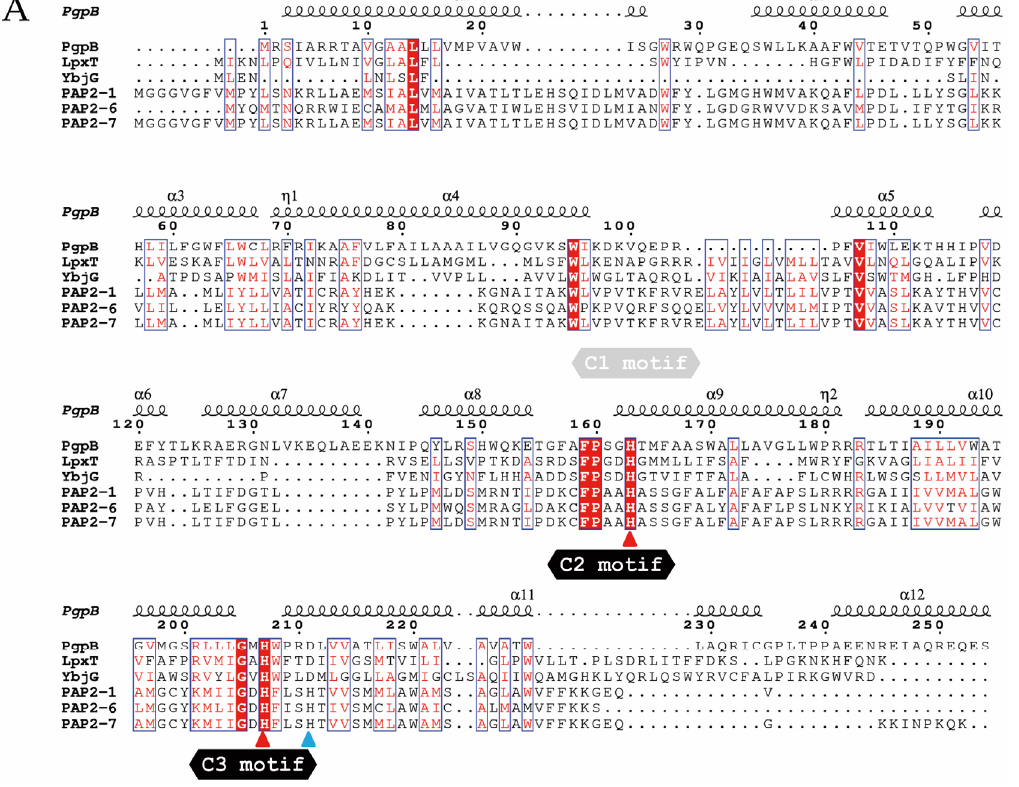
Figure 8. Structural determinants of hPAP2 and DAGK proteins. Multiple sequence alignments were performed by Clustal X 2.0 and emulated by EsPript 3.0. ( A ) Secondary structure elements of PgpB (4PX7) are shown above aligned PAP2 proteins, whose sequences are as follows: PgpB, NP_415362; LpxT, CQR81684; YbjG, WP_061361528; PAP2-1, WP_095885326; PAP2-6, OOS23616.1; PAP2-7, AUR80100. All sequences shown are from E. coli except for PAP2-6 ( Moraxella pluranimalium ) and PAP2-7 ( Klebsiella pneumoniae ). The three motifs involved in substrate binding are shown, with the catalytic triad His C2 –Asp C3 –His C3 indicated by red (conserved) or blue (non-conserved) triangles [7]. ( B ) Secondary structure elements of DAGK (2KDC) are shown above aligned proteins, whose sequences are as follows: DAGK-Eco, NP_418466.1; DAGK-3, WP_039026395.1; DAGK-7, AUR80099; DAGK-8, AVX52228. All sequences shown are from E. coli except for DAGK-7 and DAGK-8 ( K. pneumoniae ). Key residues for protein functioning that were previously determined are indicated by blue (role in activity) or red (role in folding) triangles [5]. The moderated increase in bacitracin resistance conferred by the expression of mcr-1 or mcr-3 genes could be mediated by the strong decrease in pmrR , which may result in a higher level of LpxT activity, and/or by the reduction of the negative charge around bacterial cells that blocks interactions